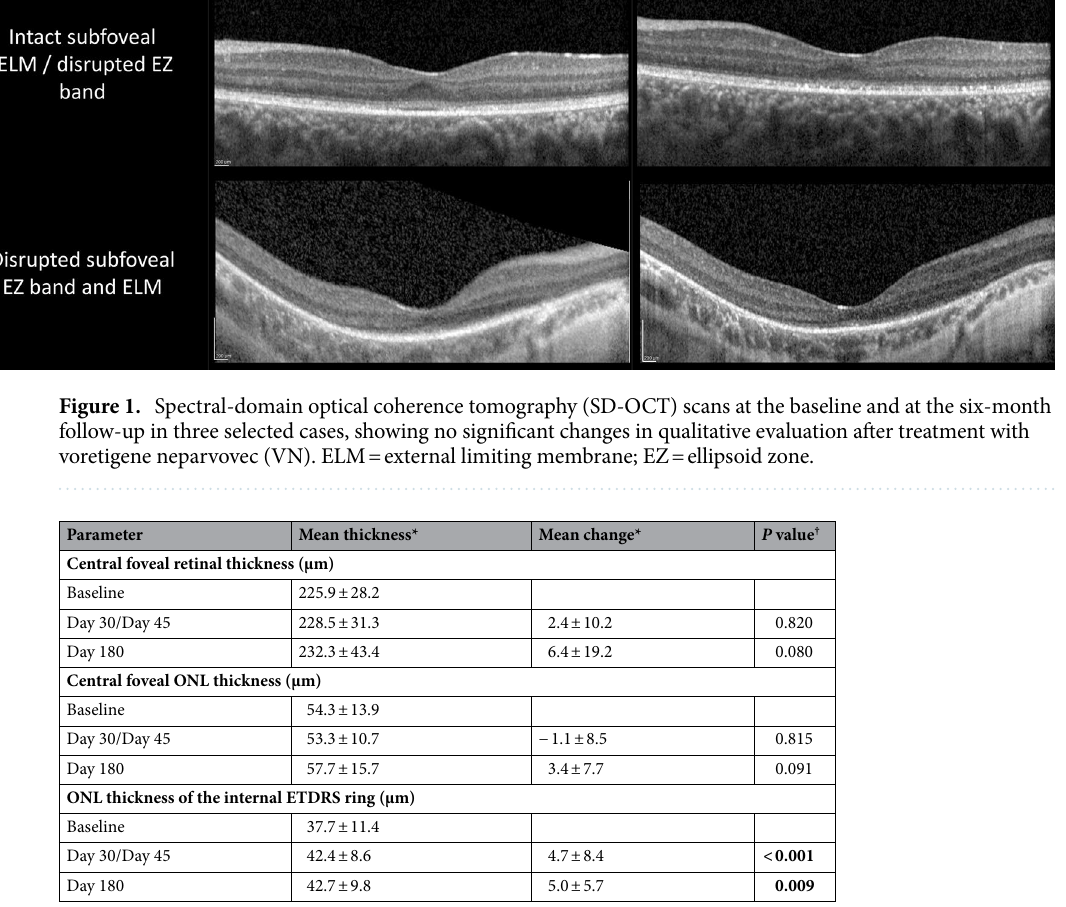
Table 3. Change of the selected spectral-domain optical coherence tomography parameters over the 6-month follow-up period. ETDRS early treatment diabetic retinopathy study, OCT optical coherence tomography (OCT), ONL outer nuclear layer. *Data reported as mean ± standard deviation. † p -values are obtained by generalized estimating equation regression models; statistically significant p -values are shown in bold.